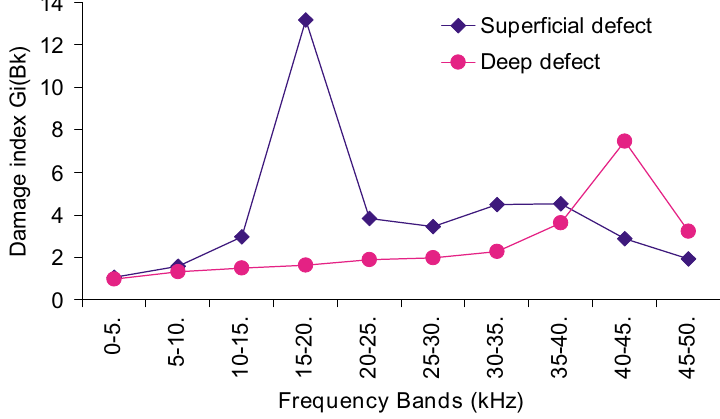
Fig. 5. Comparison between the Damage Index computed, starting from experimental data of the aluminium plate, for a superficial and a deep defect respectively in different frequency bands. where N is the number of measurement